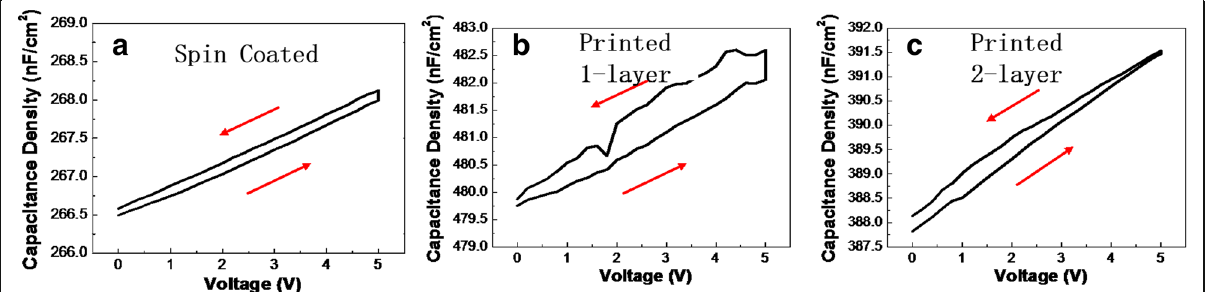
Fig. 4 Capacitance density of a SC, b DP1-layer, and ( c ) DP2-layer ZrO 2